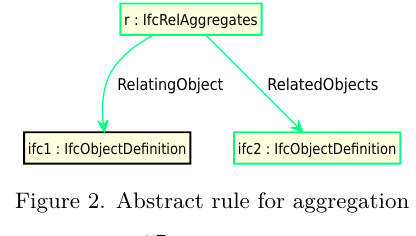
Figure 2. Abstract rule for aggregation